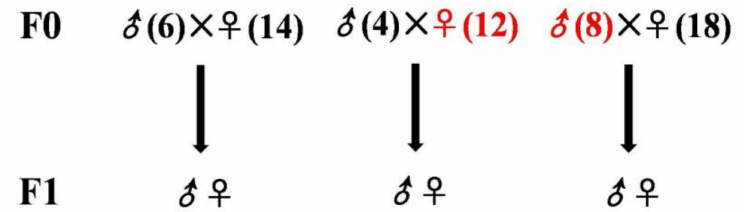
Figure 2. Generation of three cross breeds to examine the inheritance of fatty liver. The control group ( left ) using JXH chickens fed with the basal diet, maternal inheritance group ( middle ) and paternal inheritance group ( right ) using JXH chickens with HF diet-induced fatty liver. Chickens from F0 with fatty liver are shown in red while those without fatty liver are in black. the hen, respectively. Table 2. The diets for Jingxing-Huang (JXH) chicken in F0 and F1